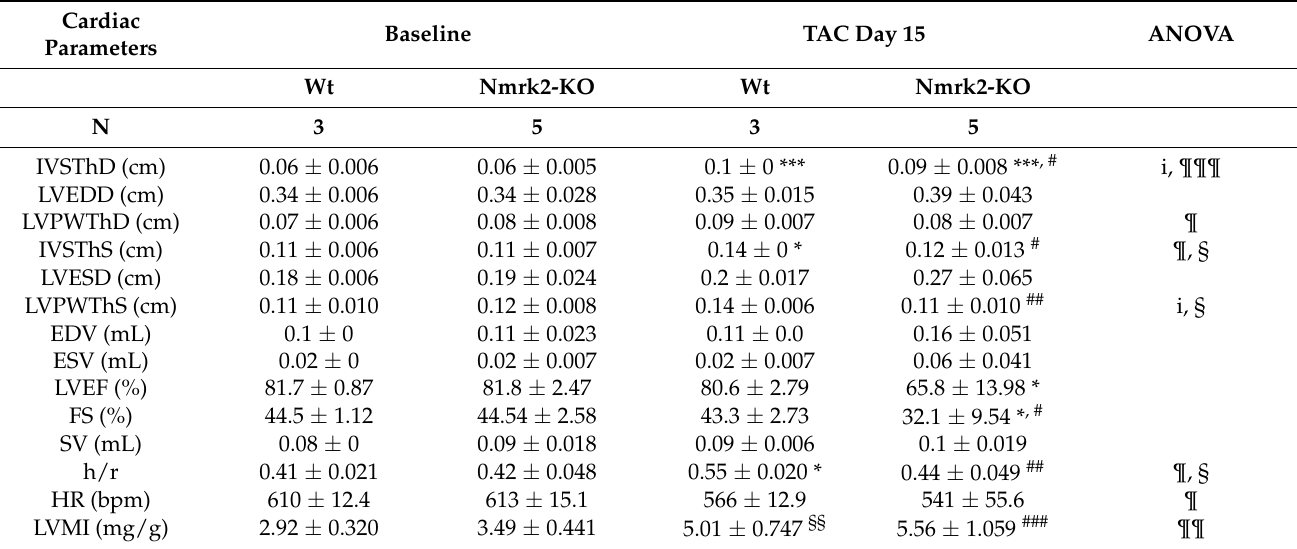
Mice series related to Figure 3. Abbreviations: IVSThD and IVSThD, interventricular septum thickness, in diastole and systole, respectively LVEDD and LVESD, left ventricle (LV) end-diastolic and end-systolic diameter; LVPWTh, LV posterior wall thickness; EDV and ESV, end-diastolic and end-systolic volume; LVEF, LV ejection fraction; FS, fractional shortening; h/r, LV mean wall thickness/radius ratio; HR, heart rate in beats per minute. Two-way repeated measure ANOVA for independent samples: i, p ≤ 0.05 for the interaction effect; ¶, p ≤ 0.05; ¶¶, p ≤ 0.01; ¶¶¶ p ≤ 0.001 for the TAC effect; § p ≤ 0.05, §§ p ≤ 0.01 for the genotype effect. Post-hoc Sidak’s multiple comparison test: *, p ≤ 0.05; ***, p ≤ 0.001 TAC vs baseline within the same genotype; #, p ≤ 0.05, ##; p ≤ 0.01; ###, p ≤ 0.001, Nmrk2-KO mice vs Wt within the TAC